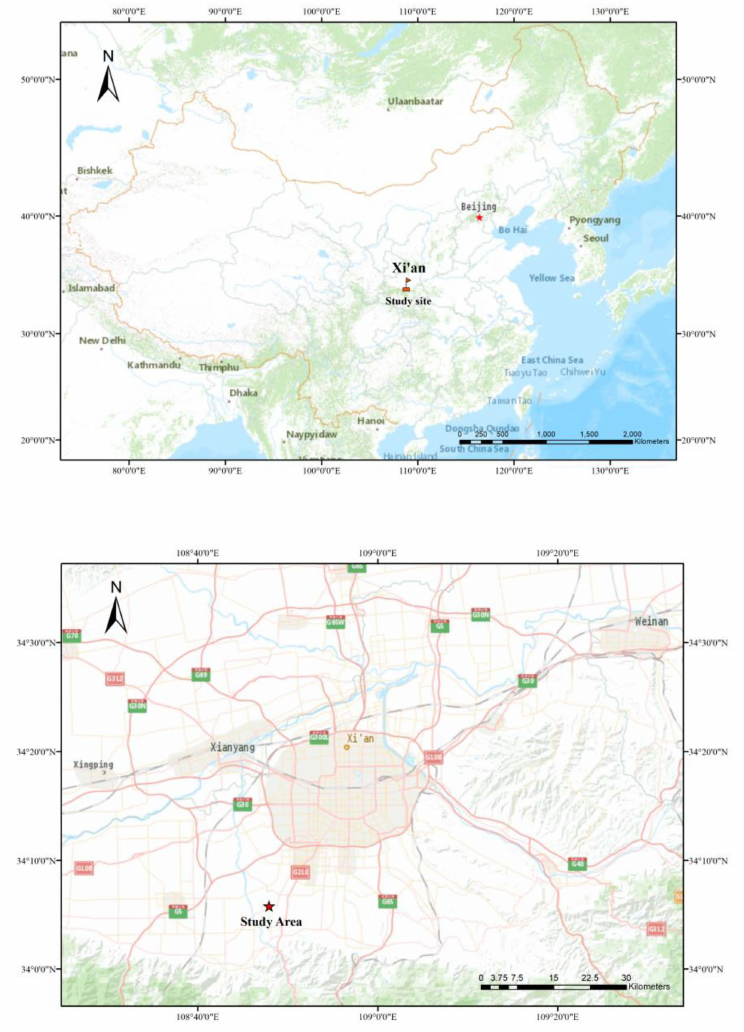
Figure 1. The specific location of the study